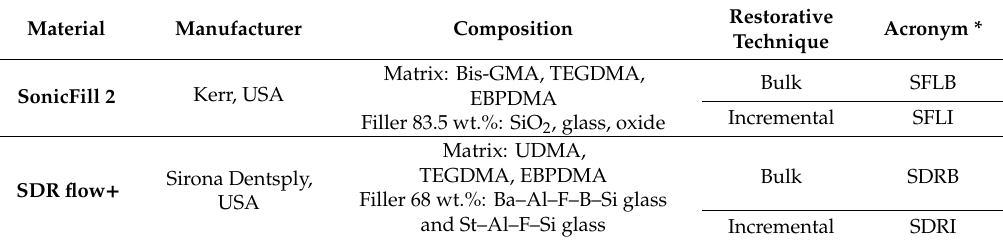
Table 1. Composite material composition and restoration